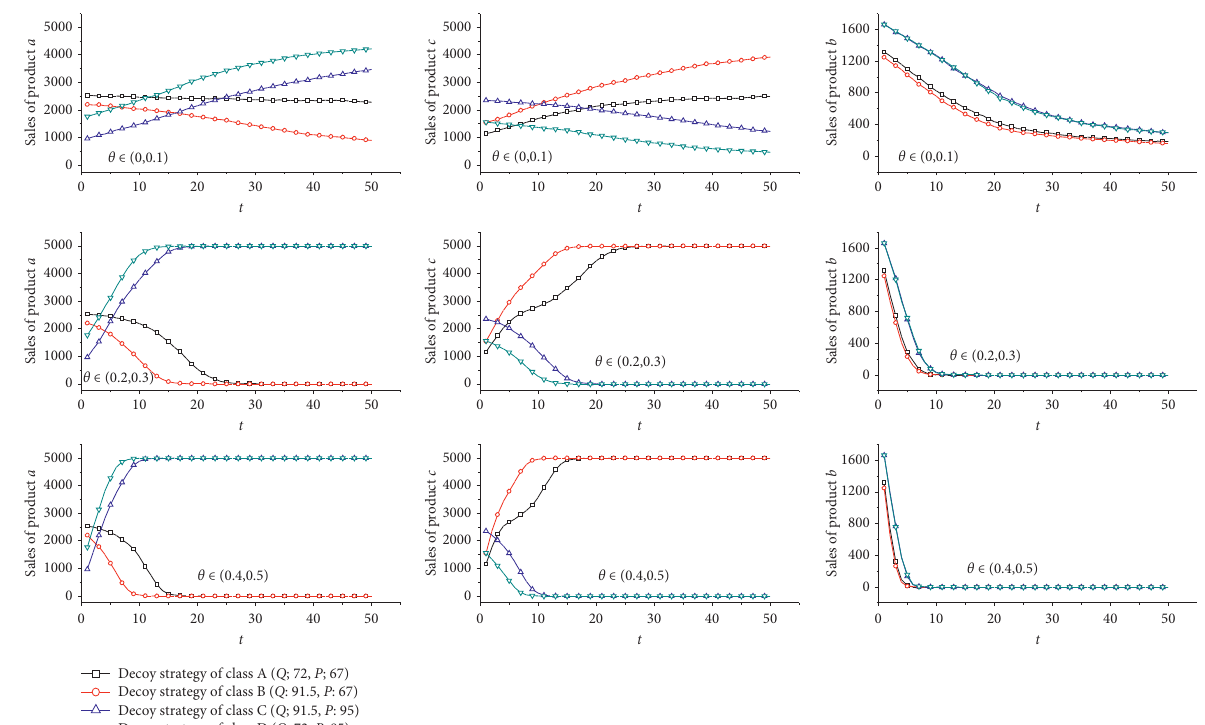
Figure 11: Evolution trends for sales of products a , c , and b under different true decoy strategies in scenarios with different herd strengths.